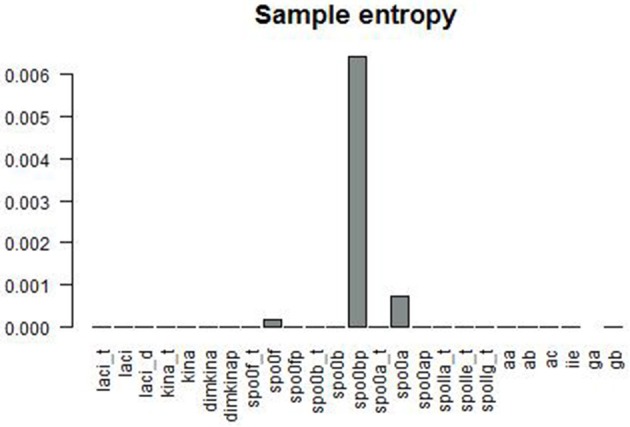
Sample entropy is a measure the repeatability or predictability within a time series. spo0bp has a sample entropy about six times greater than the sample entropy of the other molecular species.